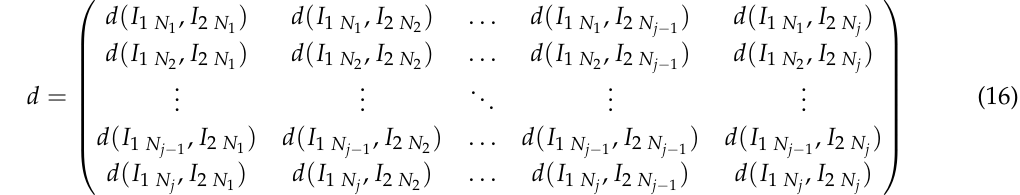
Figure 6. Calculation of the dissimilarities of Node 2 of Individual 1 ( I 1 N Individual 2 ( I 2 ) . The dissimilarity between I 1 N determined through the Hamming distance with the rest of the nodes of I 2